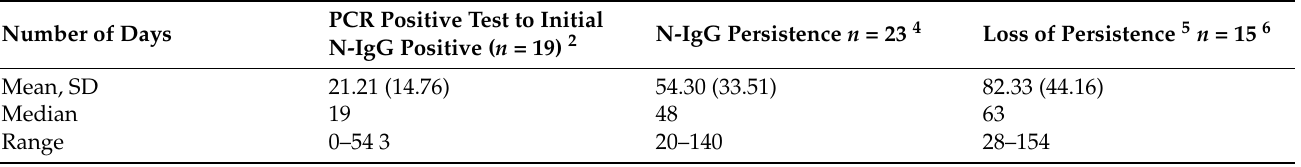
SD, standard deviation. 1 Serology was offered approximately every 30 days from date of first collection, excluding December 2020. 2 Three participants were missing date of positive PCR test. One participant